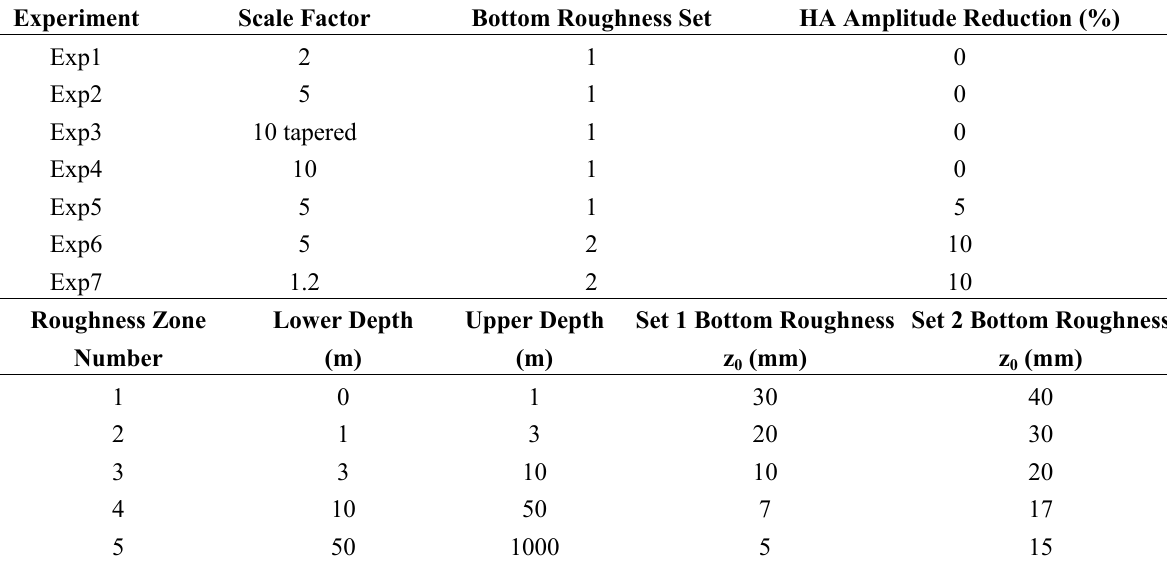
Table 1. Delta Inflow Bottom Friction Experiment Summary. The scale factor was used to multiply bottom roughness in model domain above Carquinez Strait. The tapered scale factor ranges from 1 to the full value in a linear fashion from Carquinez Strait to the river inflows based on longitude. The bottom roughness sets are given in the second table. The HA amplitude reduction corresponds to reducing the amplitudes of the offshore boundary harmonic